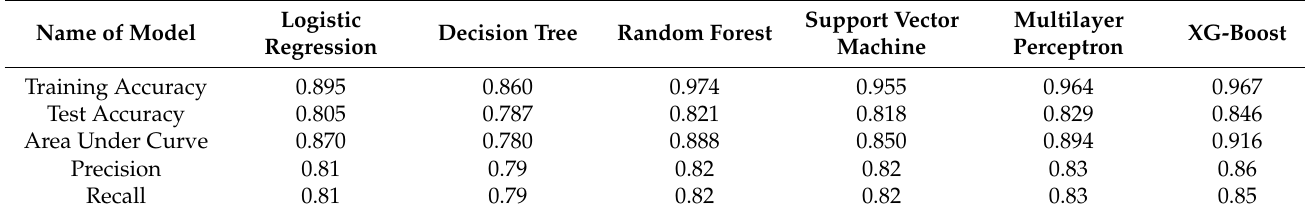
Table 2. The table indicates the statistical value of different ML models.